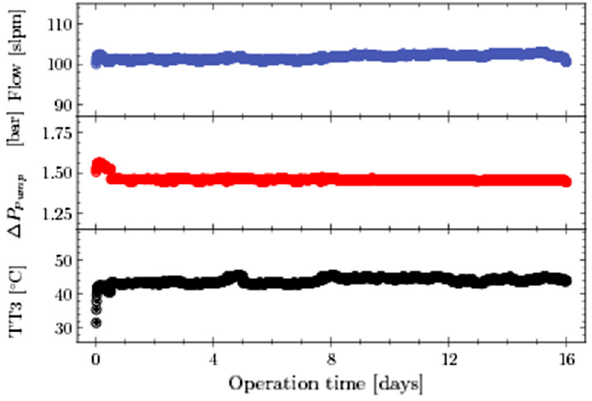
Fig. 18 Demonstration of longterm stability of the pump using xenon ataninletpressureof1.45bar.Theperformanceparametersflow(blue), differential pressure (red) and temperature at the compression volume beneath the top flange (black) are